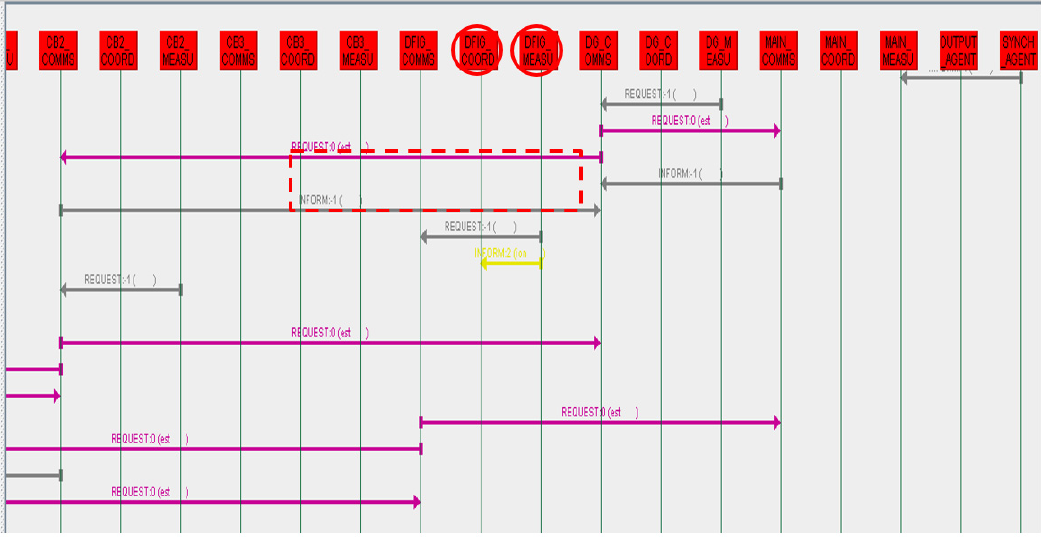
Figure 20. Message communication between protection agents within the protection IED at the CB DFIG in MAPS.